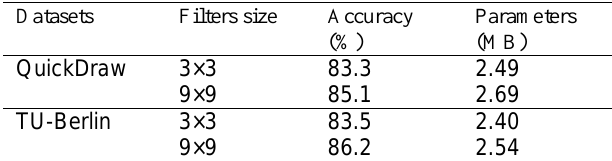
Table 3. Effect of larger depthwise convolutional layer